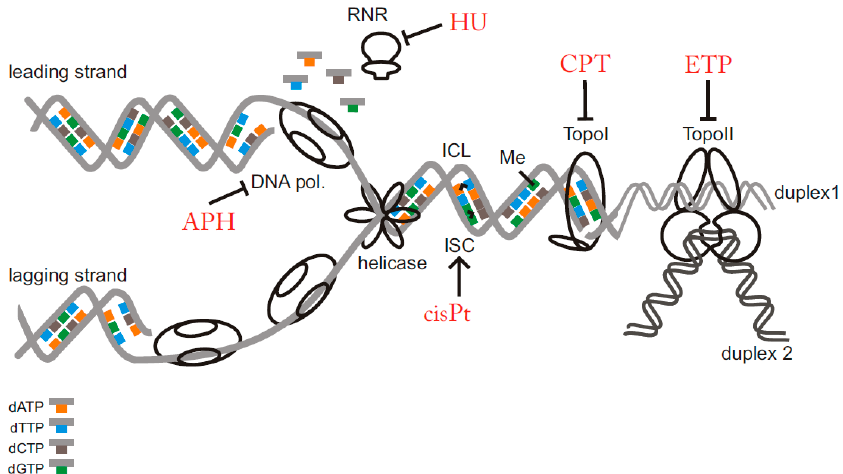
Figure 1. Schematic view of the most common lesions causing replication stress. In the scheme, several important replication stress (RS) inducing factors are illustrated: intra ‐ strand crosslink (ISC), inter ‐ strand crosslink (ICL), alkylated/modified base (Me) and inhibition of replication related enzymes. Compounds further described in the review are marked by red colour. RNR: ribonucleotide